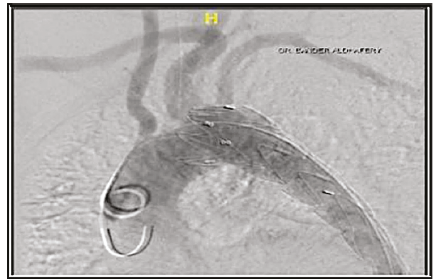
Figure 3: Intraoperative angiogram after stent placement.